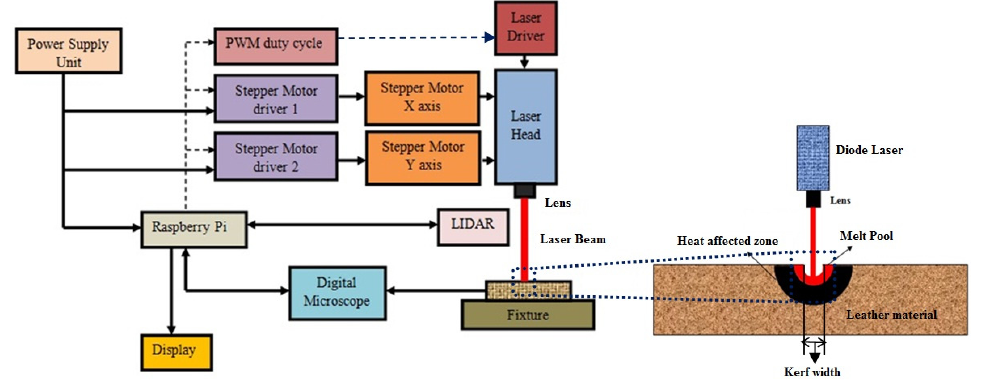
Figure 2. Functional block diagram of the proposed system.